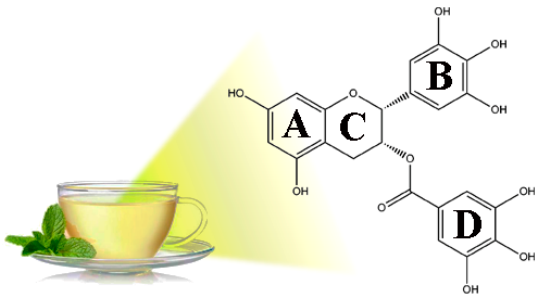
Figure 1. Structure of epigallocatechin-3-gallate, a green tea polyphenol.